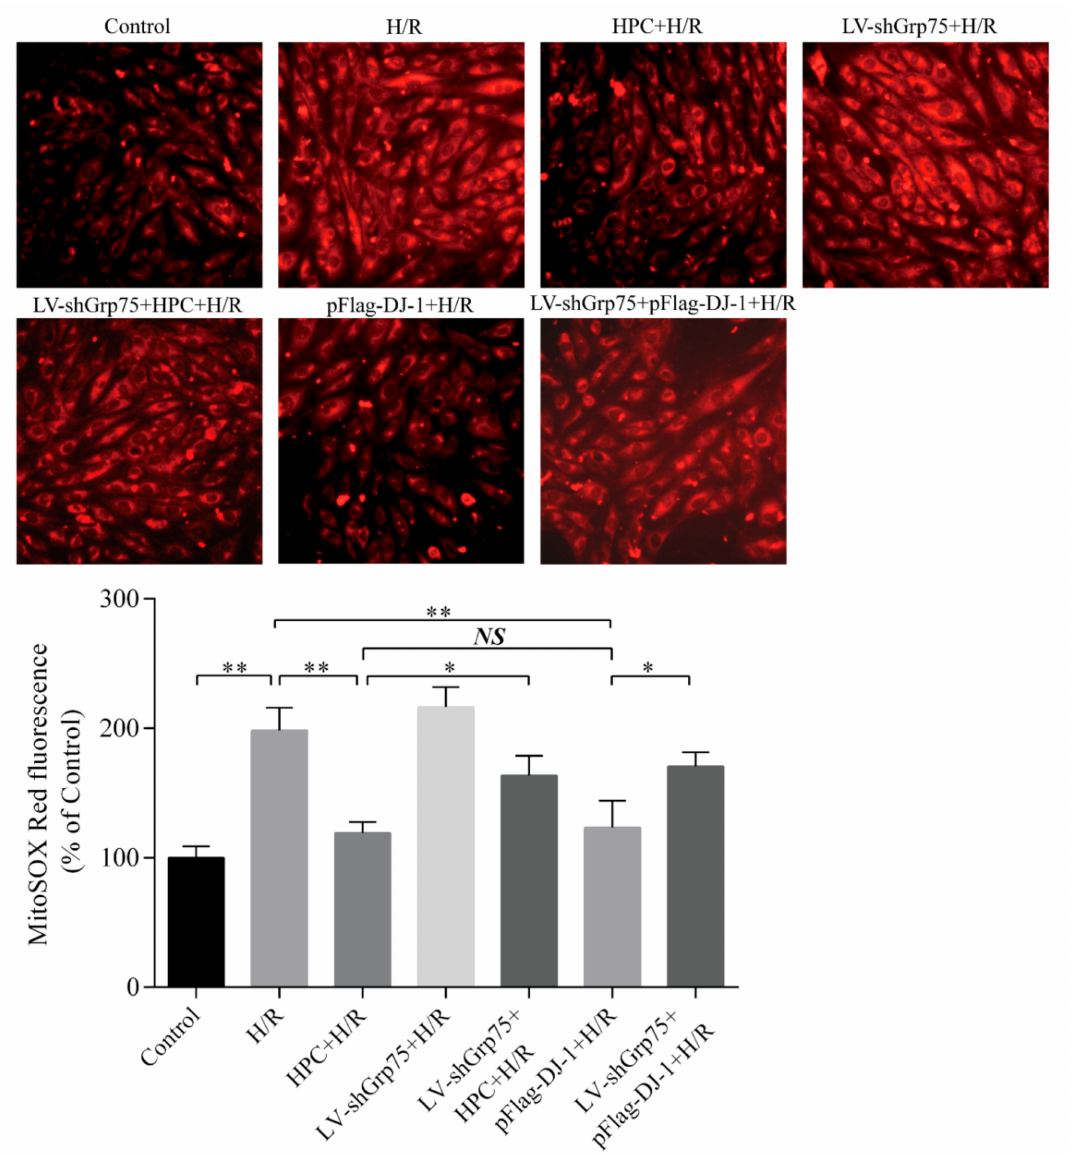
Figure 6. E ff ects of Grp75 knockdown on DJ-1-mediated inhibition of mitochondrial ROS generation by hypoxic preconditioning (HPC) in H9c2 cells subjected to hypoxia / reoxygenation (H / R). H9c2 cells were infected by lentiviral (LV) vectors LV-shGrp75 for 72 h and then subjected to HPC 24 h prior to H / R or transfected with pFlag-DJ-1 for 48 h followed by H / R. Subsequently, the mitochondrial SOX generation was measured by a MitoSOX Red fluorescent staining. ( A ) Representative fluorescence images of mitochondrial ROS observed with MitoSOX Red probe by fluorescent microscope (200 × ). ( B ) Quantitative analyses of MitoSOX Red fluorescence intensity in di ff erent treatment cells using a fluorescent plate reader. Each value represents the mean ± SD of three independent experiments. * p < 0.05, ** p < 0.01 as indicated on the figure. NS indicates no